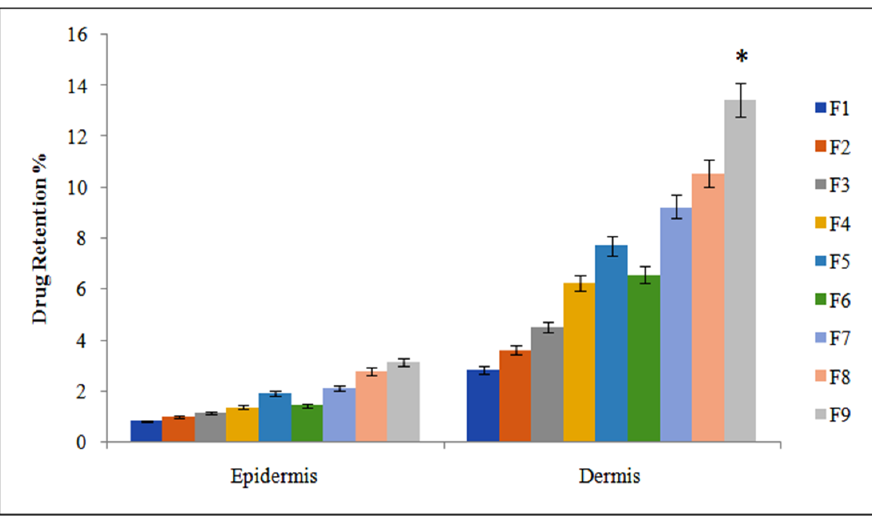
Figure 5. Skin drug retention analysis of methotrexate patches (F1–F9). Dataare expressed as mean ± SD; n = 3. One-way ANOVA followed by post hoc Tukey test ( p < 0.05), F9 vs. F1.